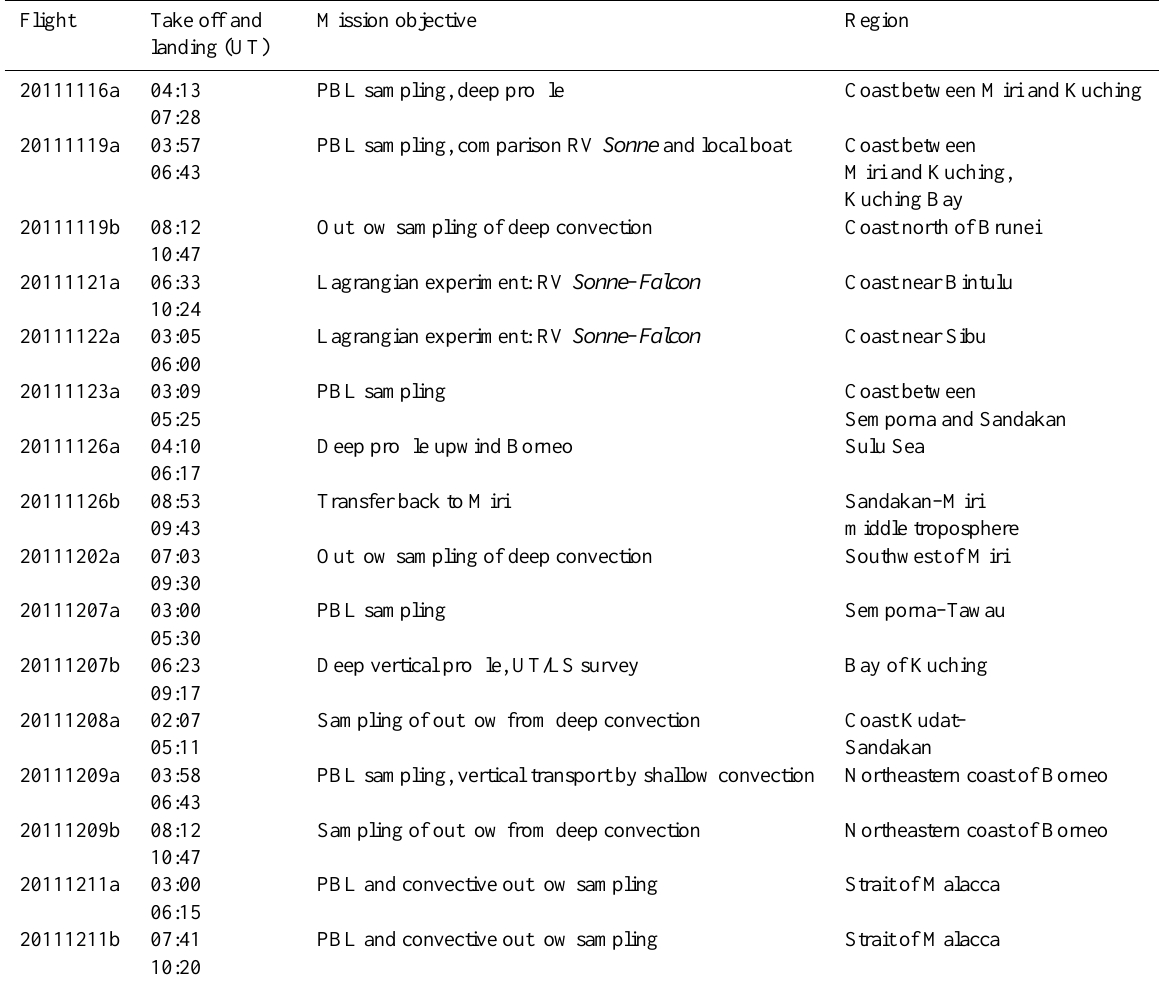
Table 1. Overview of the 16 measurement flights during the SHIVA aircraft campaign. Abbreviations are as follows: PBL, planetary boundary layer; RV, research vessel; UT/LS, upper troposphere/lowermost stratosphere. The different flight regions are shown in detail in Fig.